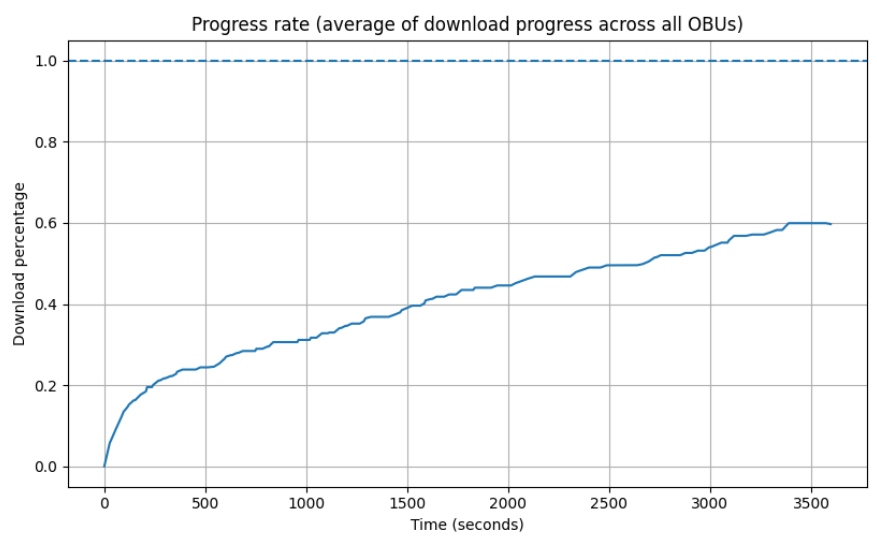
Figure 13. Progress rate of a 50 MB file distributed across 200 nodes from 15 h to 16 h in EmuCD running